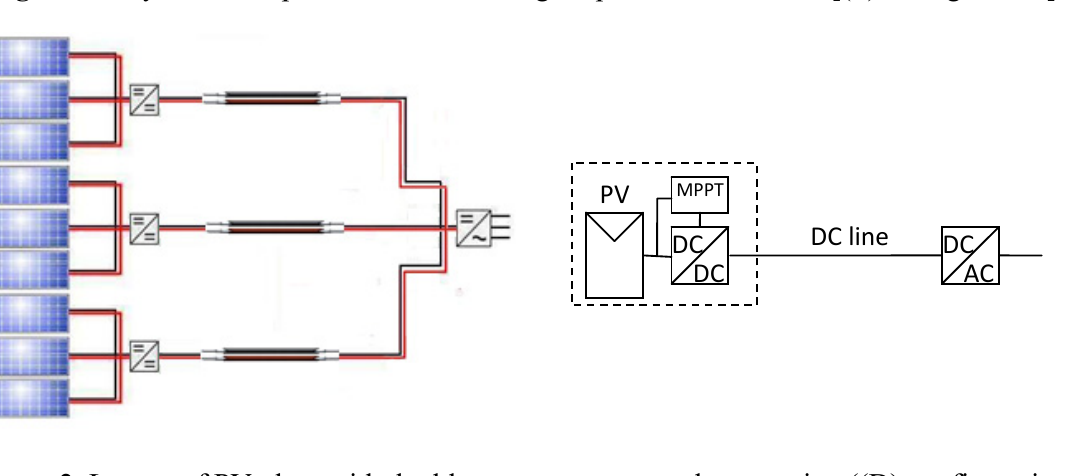
Figure 1. Layout of PV plant with double-stage separated conversion [(F) configuration].